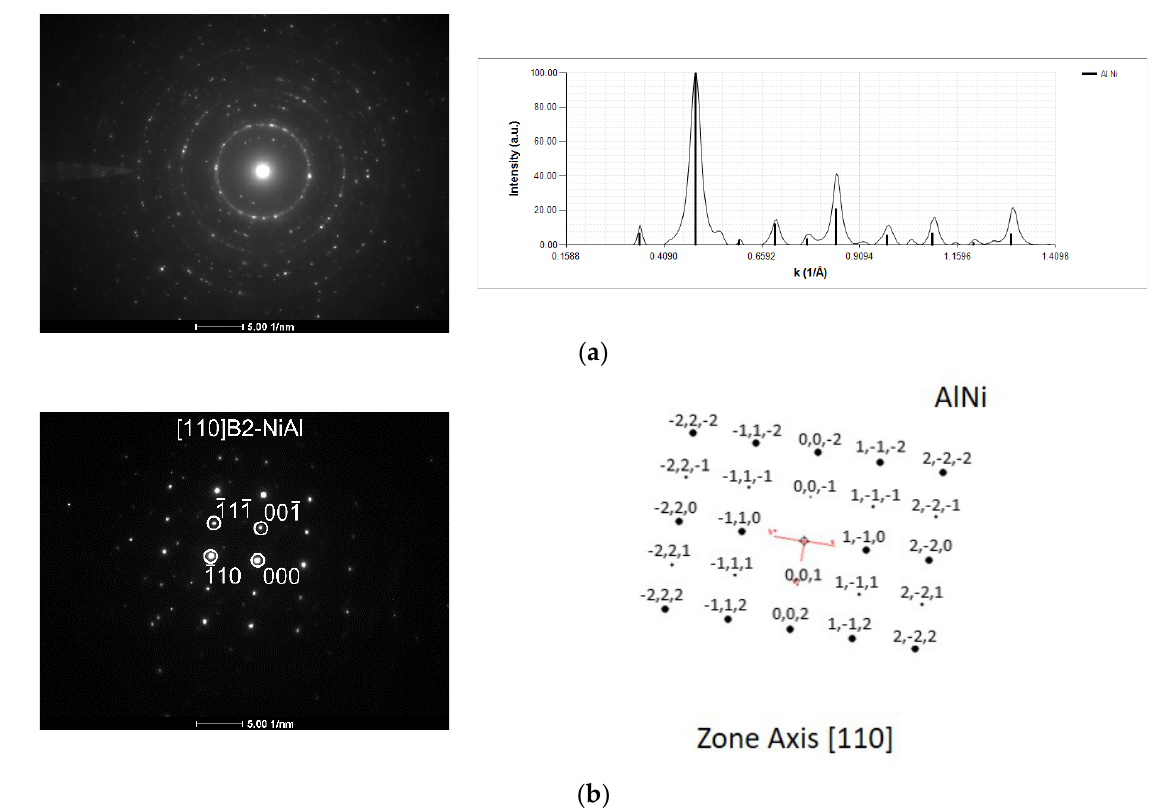
Figure 13. SAED patterns and respective indexation of the Al/Ni thin film after ignition by mode II ( φ = 0.05 mm W wire). ( a ) large SAA (100 µ m real diameter), and ( b ) small SAA (10 µ m).